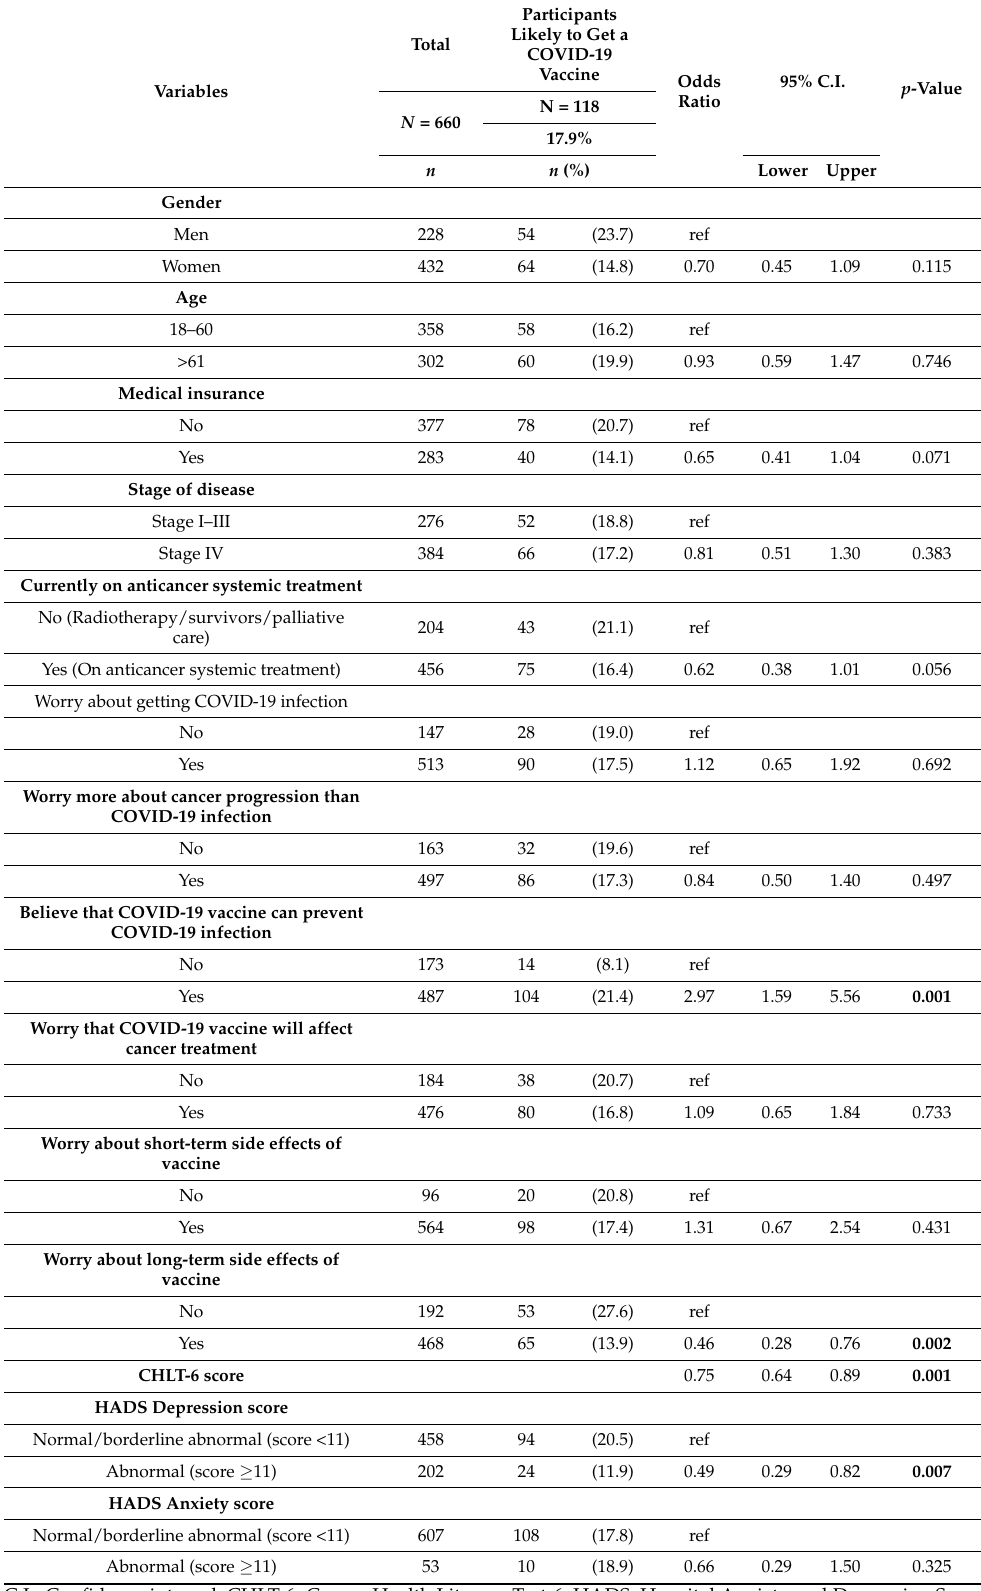
Table 2. Multivariable analysis on factors associated with acceptance of COVID-19 vacci-